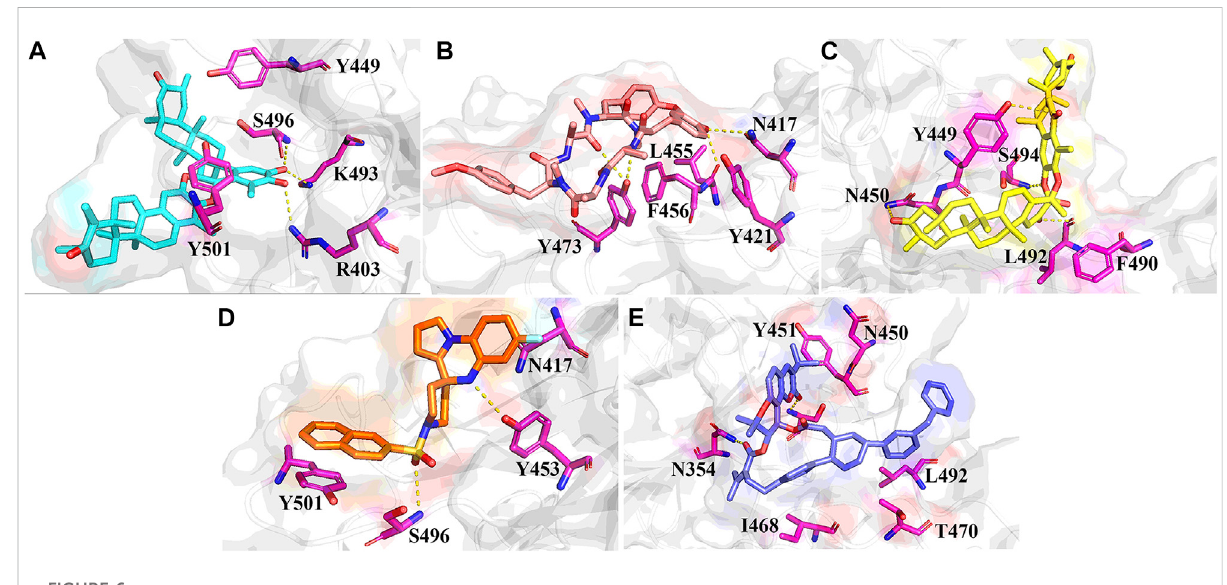
FIGURE 6 Stable binding conformations between the fi ve candidate compounds and the RBD protein after 100ns MD simulation. (A) ZINC95919448; (B) ZINC85531210; (C) ZINC95610651; (D) ZINC000035399302; (E)